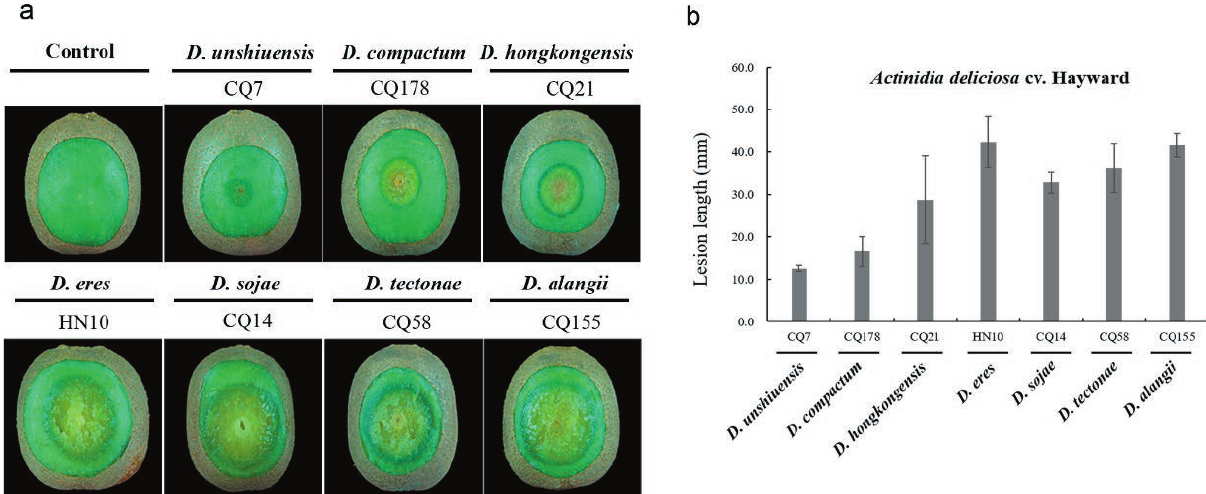
Figure 7. Symptoms and mean lesion lengths caused by inoculation of wounded kiwifruit fruits ( Actinidiae deliciosa ‘Hayward’) with myce- lium plugs from cultures of seven Diaporthe spp. a, representative symptoms photographed at 10 d post inoculation. b, mean lesion lengths (four replicates) measured at 7 d